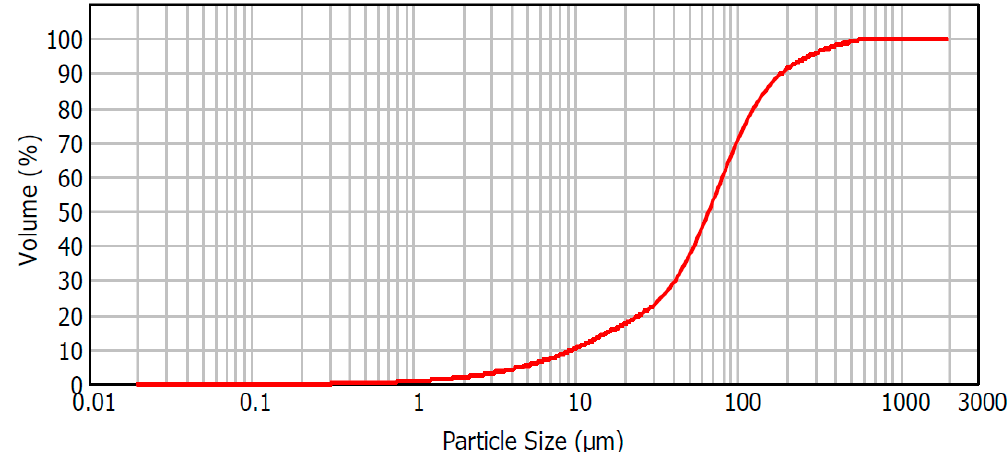
Figure 1. Cumulative particle size distribution of coal—Grain size 0–0.5 mm.